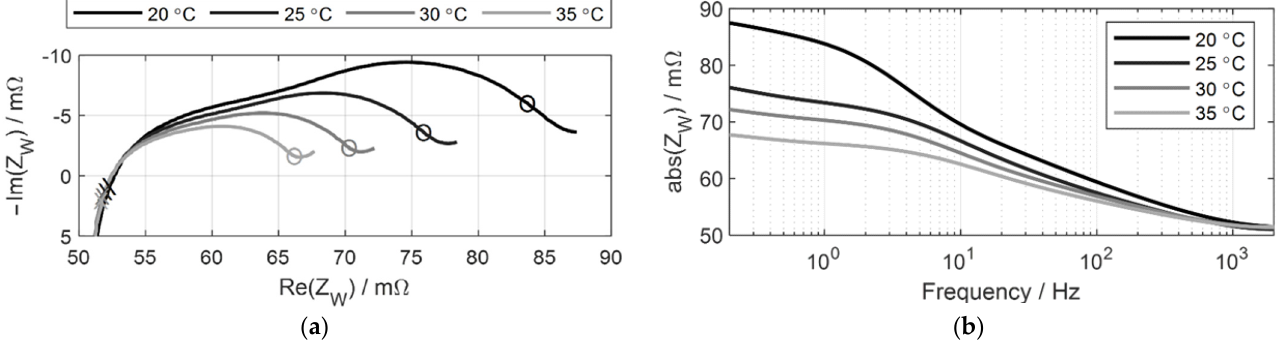
Figure 7. Cell impedance at each frequency at 20, 25, 30, and 35 °C. ( a ) Nyquist plot (O: 1 Hz, X: 1 kHz); ( b ) Bode plot. As shown in Figure 7, the higher the cell temperature, the lower the cell impedance,